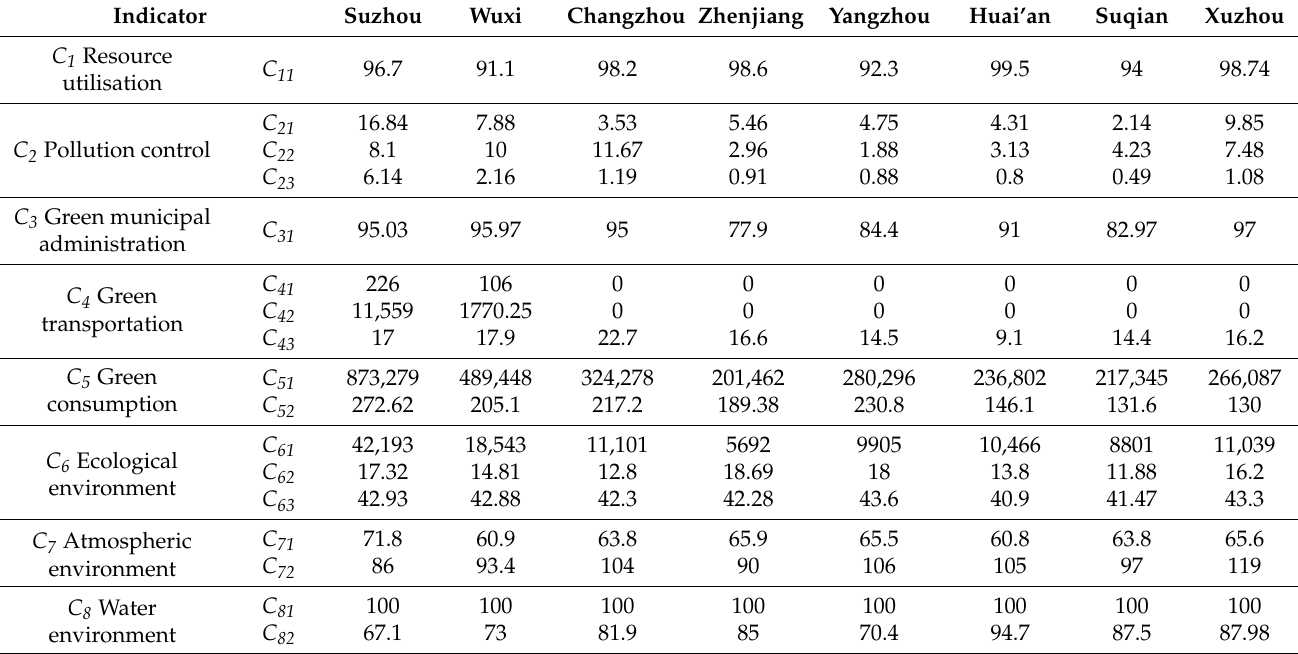
Table A2. Quantitative data on evaluation indicators for 2014.